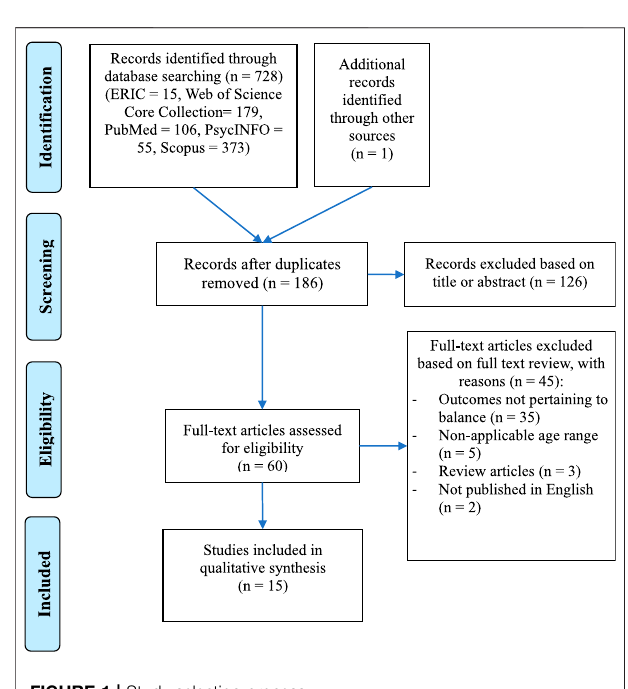
FIGURE 1 | Study selection